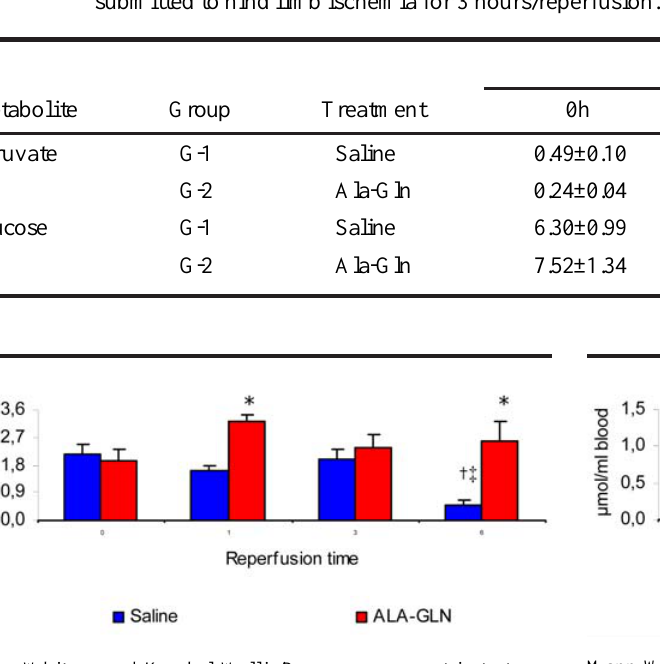
FIGURE 2 - Blood lactate concentrations in saline and L-alanyl-glutamine treated rats.